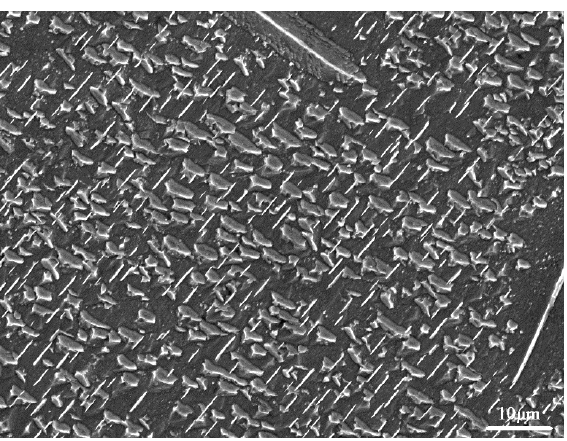
Figure 3. SEM images of cross-sections of the simplex nitrided (SN) sample ( a ) and duplex surface treated (DST) samples ( b – f ).